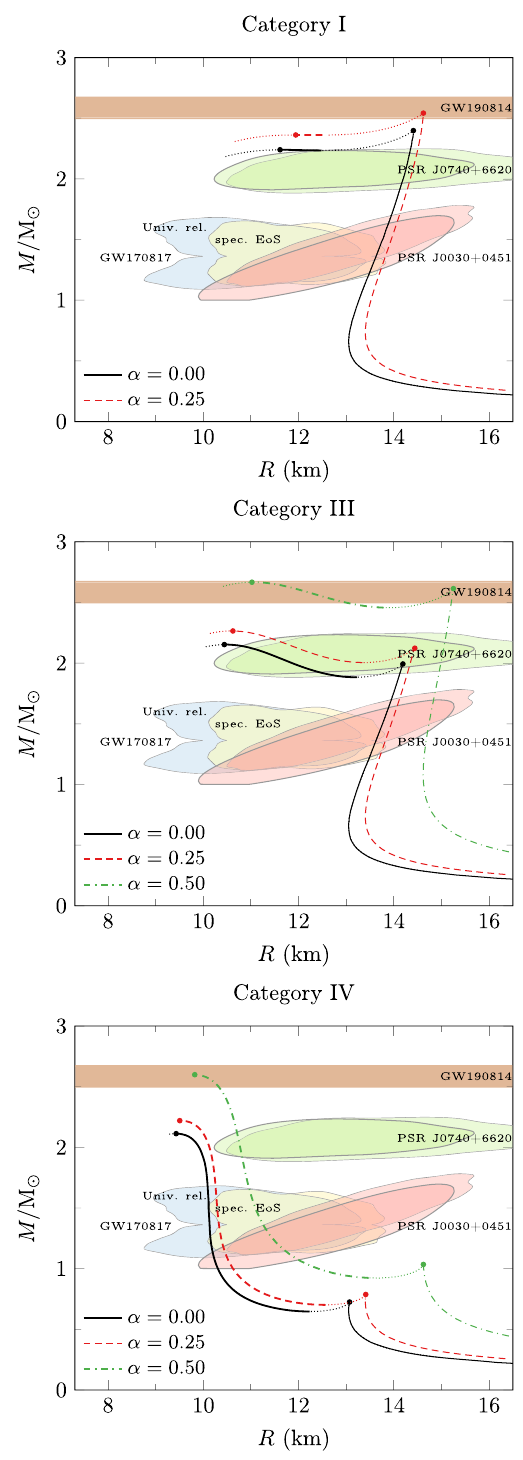
Fig. 3 Predictions of the CSS model for the mass–radius profile of the charged twin stars considering the Categories I, III and IV. The results for the neutral counterparts are also presented for